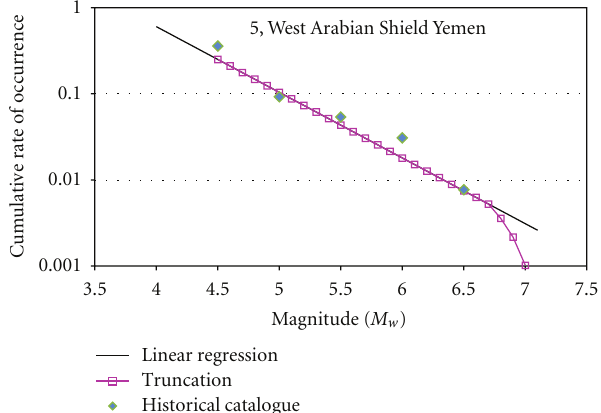
Figure 6: Normal regression and truncation model plot of cum- ulative number of events per year for the source 5, West Arabian Shield Yemen. Cumulative rates from historical catalogue, showing the Poissonian distribution, are compared with that of